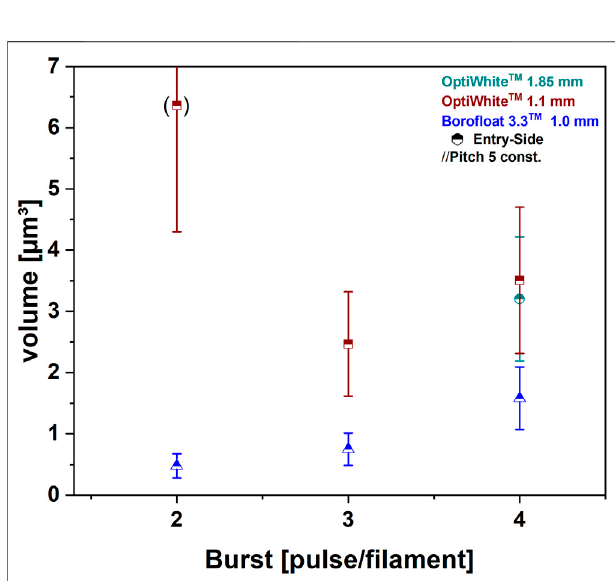
FIGURE 11 | Calculated volume of the surface modi fi cations at the Entry-Side in relation to the Burst. An increase can be observed which goes along with the corresponding outer diameter. The inner diameter and the height of the surface modi fi cations were found to be constant.